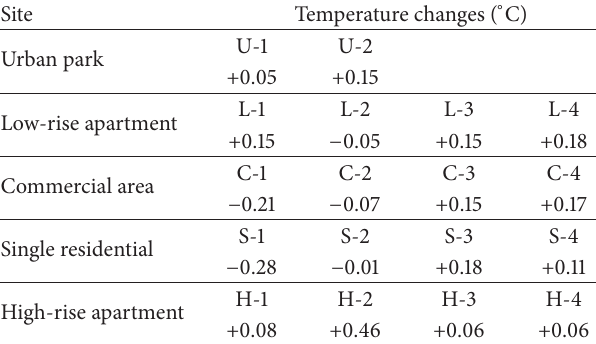
Table 5: Changes in temperature by space